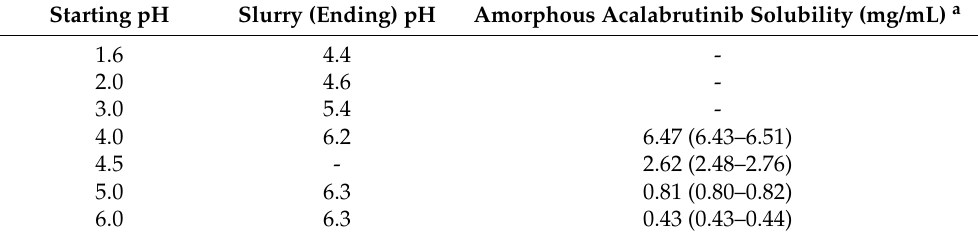
Table 3. Slurry pH and solubilities of amorphous acalabrutinib dosed as the 50/50 ( w/w ) acalabru-